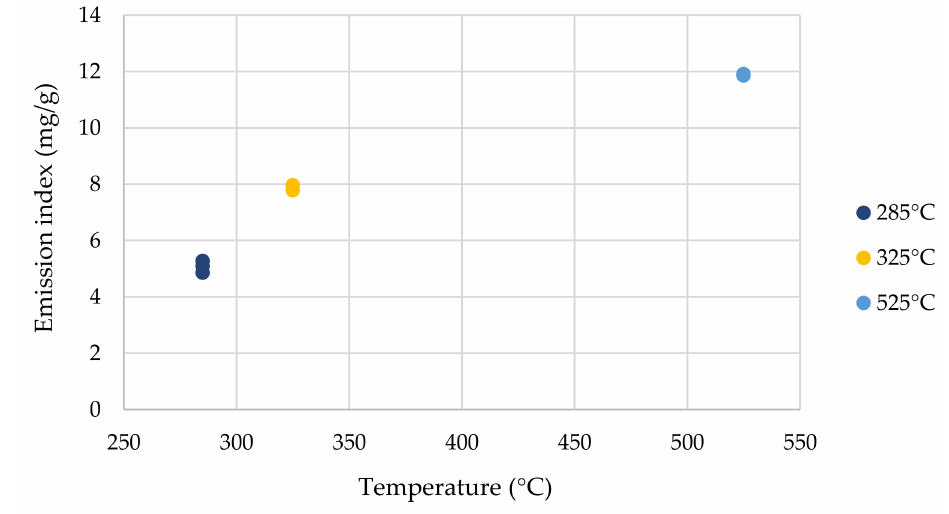
Figure 18. Values of the determined VOC total emission